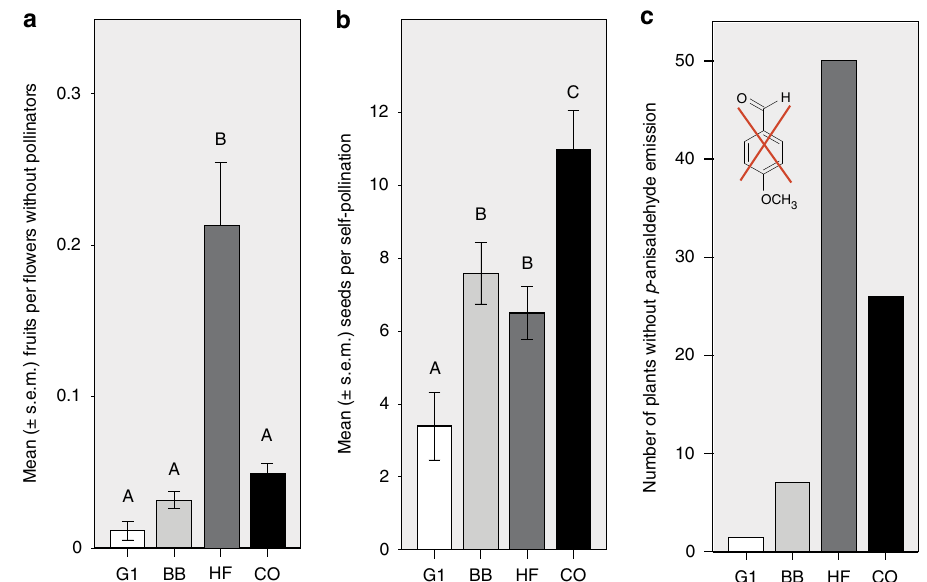
Figure 4 | Evolution of mating system and vestigialization in experimental plants. Plants of generation 1 (G1) are compared with the bumblebee-(BB), hoverfly-(HF) and hand-pollinated (CO, control) plants of generation 11. ( a ) Autonomous selfing measured as fruits per flowers produced by plants without access of pollinators (sample sizes: G1: 23, BB: 39, HF: 40, CO: 52). HF-plants evolved increased autonomous selfing (GLM: treatment: F 3,6.04 ¼ 11.04, P ¼ 0.007; different letters indicate differences between groups, LSD post-hoc tests, P o 0.001). Neither ‘seeds per fruit’ nor ‘seed weight’ were different between the groups (GLM, P 4 0.05). ( b ) Self-compatibility measured as the ‘number of seeds per self-pollinated flower’ (sample sizes: G1: 40, BB: 93, HF: 91, CO: 59). Plants of all pollination groups had elevated self-compatibility in generation 11 (GLM: F 3,6.06 ¼ 10.67, P ¼ 0.008, LSD post-hoc tests P o 0.05). ( c ) Number of plants without p -anisaldehyde emission. Frequency of plants without p -anisaldehyde was similar among first-generation and eleventh generation BB-plants ( w 2 test, w 2 1 ¼ 2.78, P ¼ 0.10), but anisaldehyde-loss was more pronounced in CO- and especially in HF-plants, where almost half of all plants had lost the emission of this volatile in generation 11 (G1-BB-HF-CO: w 2 3 ¼ 66.95, P o 0.001; HF-CO: w 2 1 ¼ 7.58, P ¼